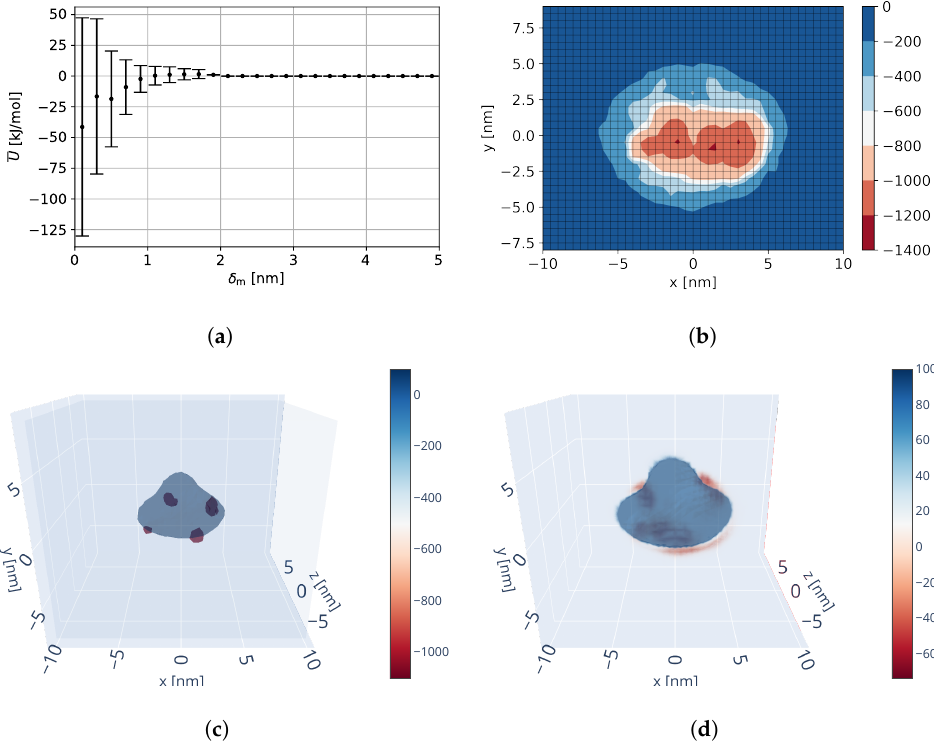
Figure 10. Visualizations of the potential field based on MD with inserted empirical data. ( a ) Average and standard deviation binned over minimum distance in grid. ( b ) X-Y cross-section minimum over all remaining dimensions. ( c ) 3D minimum over orientations. ( d ) 3D mean over orientations.